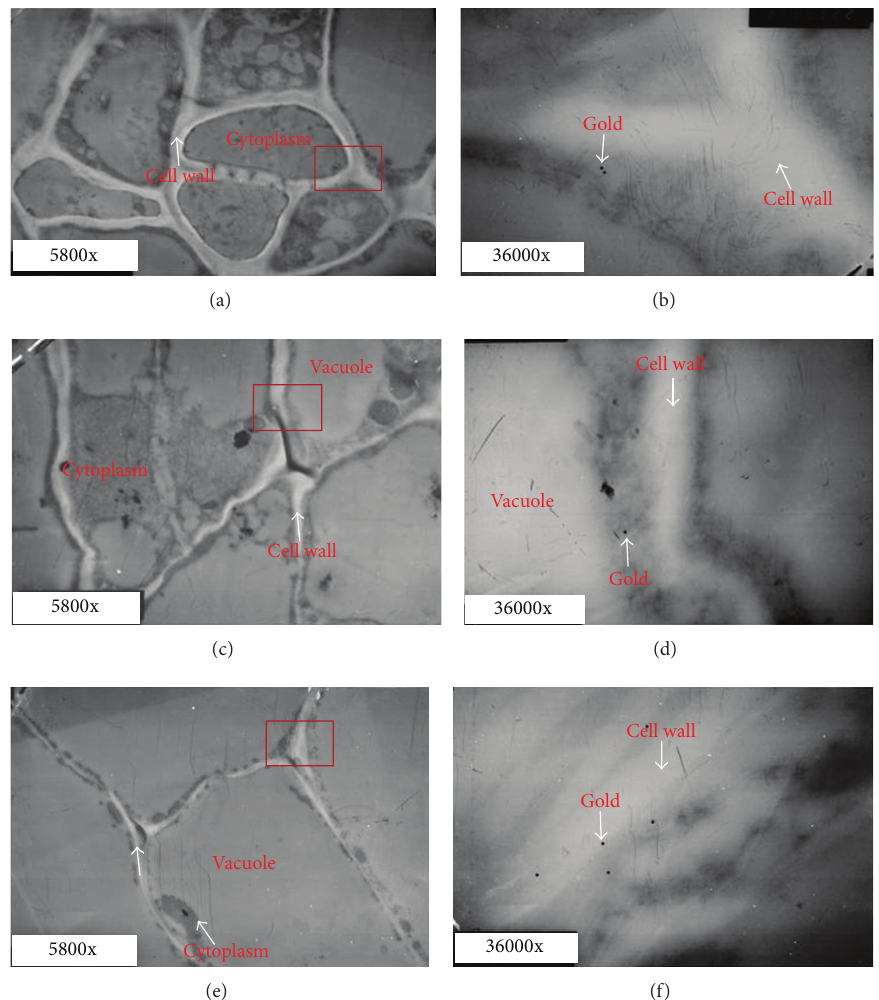
Figure 5: Transmission electron micrographs of tomato pedicel and localization of polygalacturonase (PG) in abscission zone cells by immunogold labeling (8 h). (a) and (b): cortex; (c) and (d): vascular region; (e) and (f): central parenchymatous region (b); (d) and (f) are enlarged photos for the rectangles region in (a), (c), and (e),